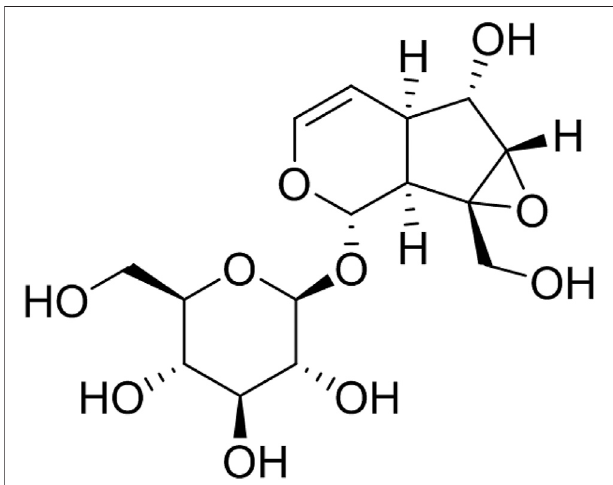
FIGURE 1 | The chemical structure of catalpol.